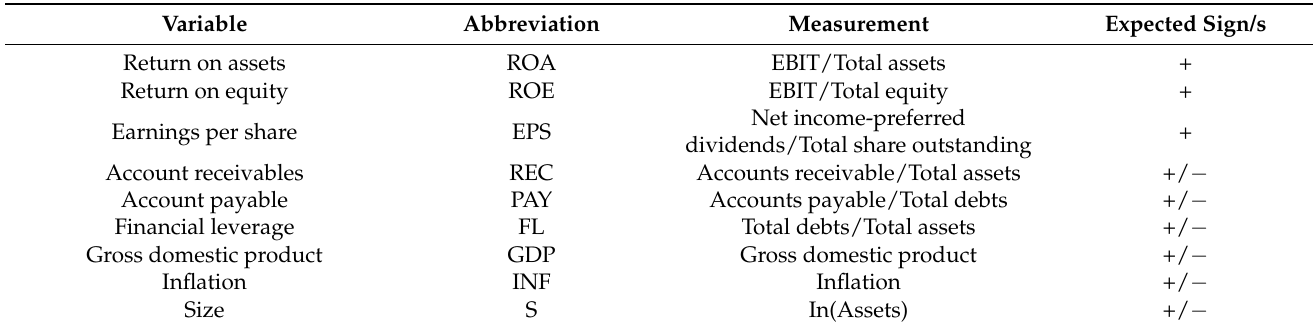
Table 1. Definitions of